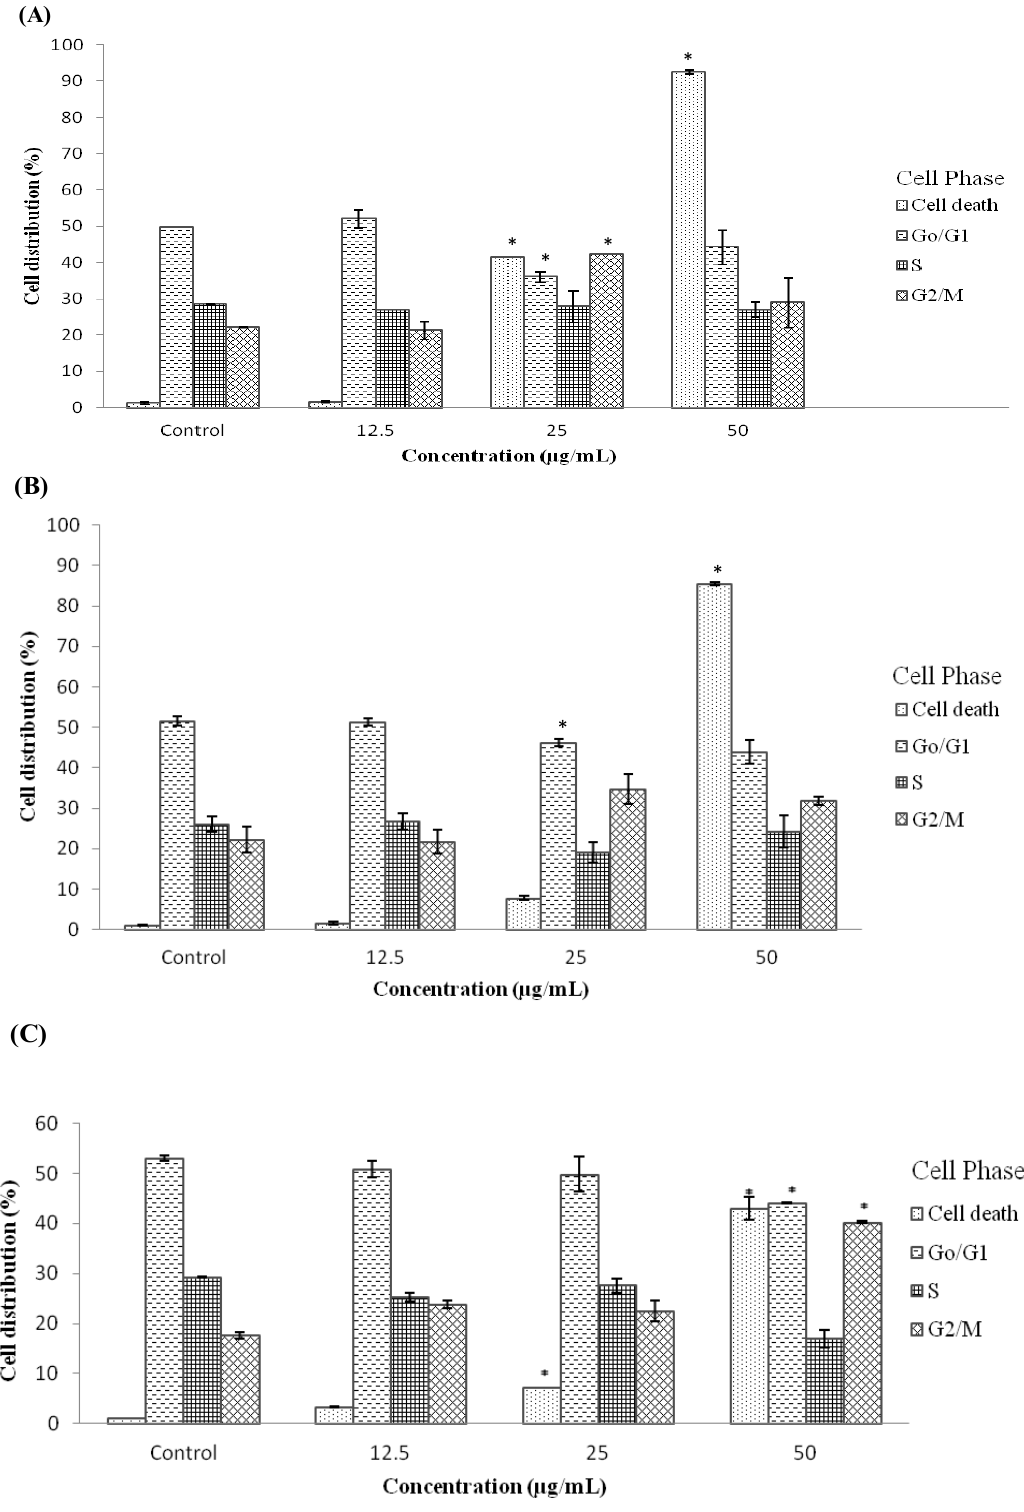
Figure 4. Effects of ( A ) D/F4, ( B ) D/F5 and ( C ) EA/P2 on the cell cycle of MCF-7 and effects of ( D ) D/F4 and ( E ) D/F5 on the cell cycle of MDA-MB-231 analyzed by flow cytometer. The cells were treated with different concentrations of D/F4 for 24 h. * p < 0.05 as compared to the untreated control cells. The data is the average value of three independent experiments ±